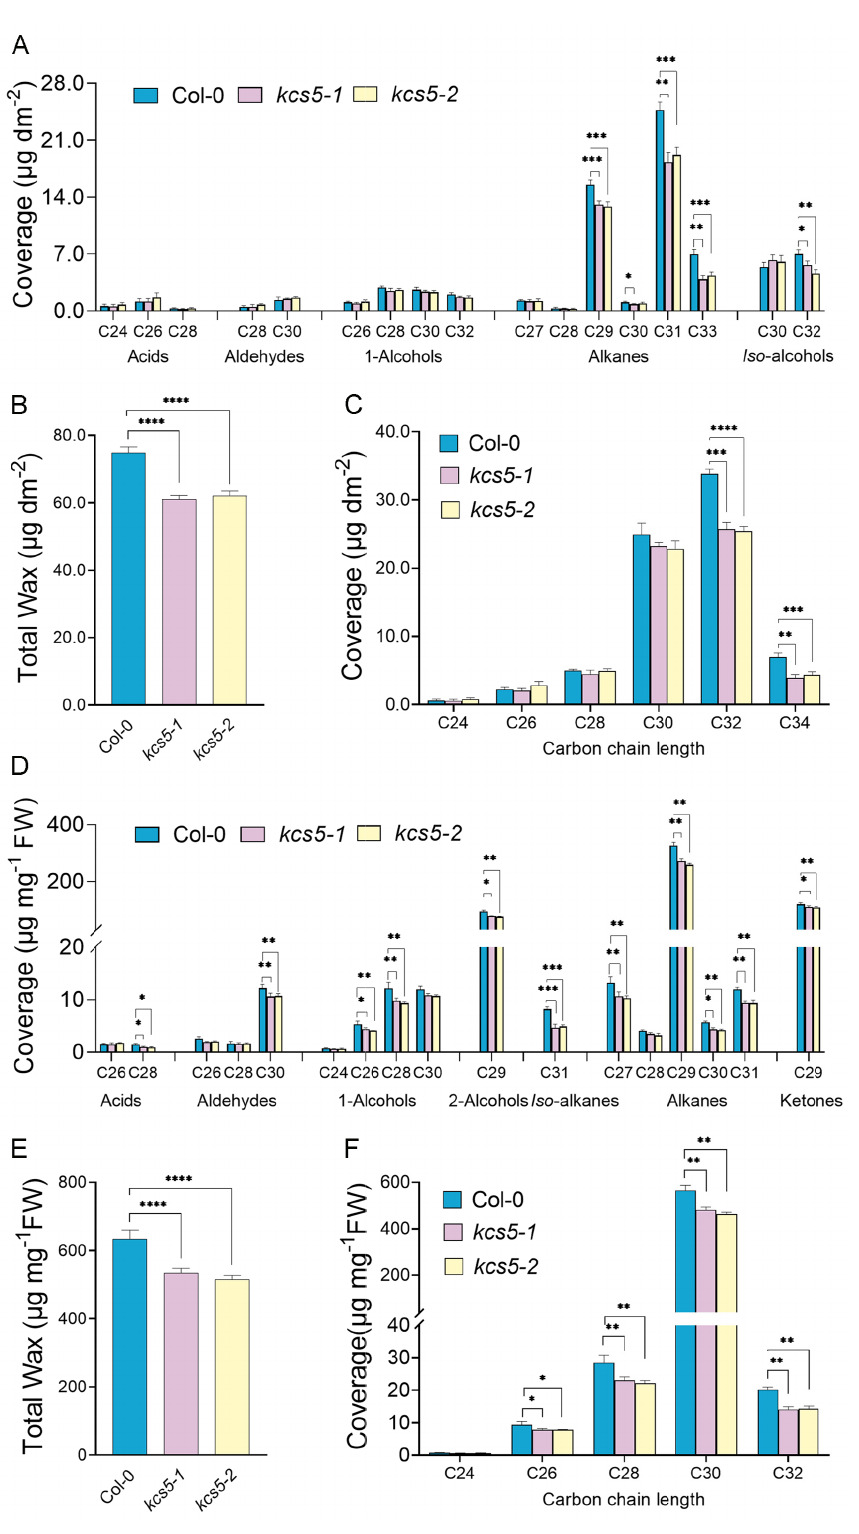
Figure 1. Wax profile in rosette leaves and flowers of kcs5-1, kcs5-2 mutants, and Col-0. ( A , D ) Amount of each wax component in rosette leaves and flowers; wax coverage is expressed as wax amounts per stem surface area ( µ g.dm − 2 ). Each wax constituent is designated by carbon chain length and labeled by chemical class along the x axis. ( B , E ) Amount of all wax components with equal carbon chain lengths in rosette leaves and flowers. ( C , F ) Total wax amounts. Data are means ± SE of five biological replicates. (* p <0.01; ** p < 0.05; *** p < 0.001, **** p <